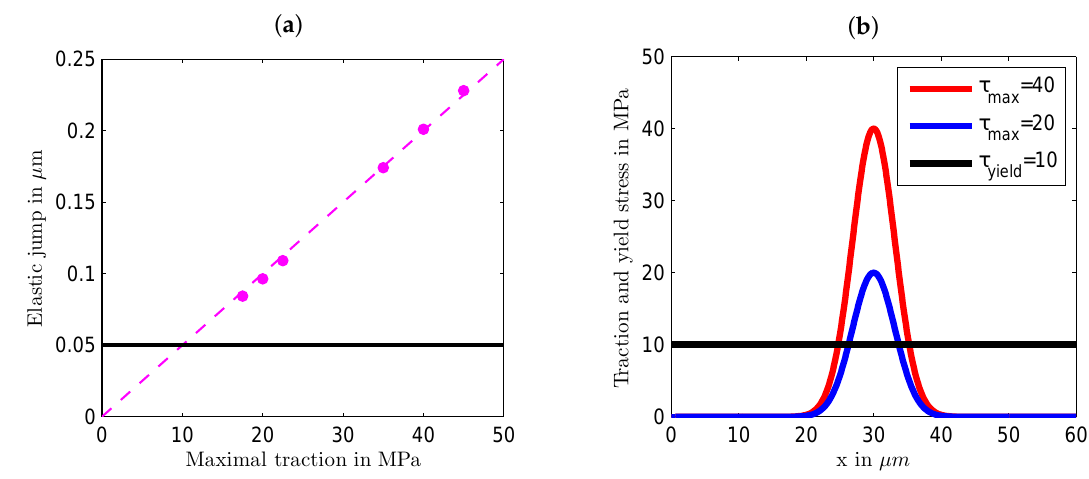
Figure 5. ( a ) The magnitude of the elastic jump ∆ z el at the stripe center is proportional to τ max , both for x and y polarized light. The black line shows ∆ z el at the yield stress. ( b ) The film area in which the stresses exceed the yield stress rapidly shrinks with the decrease of τ max . The beam radius w = 2